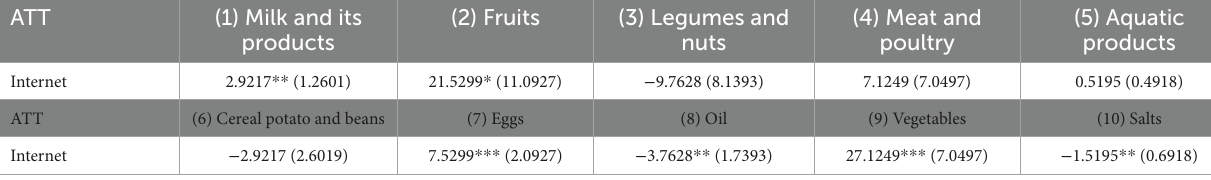
TABLE 5 Increased consumption of different categories of food by smallholder farmers with